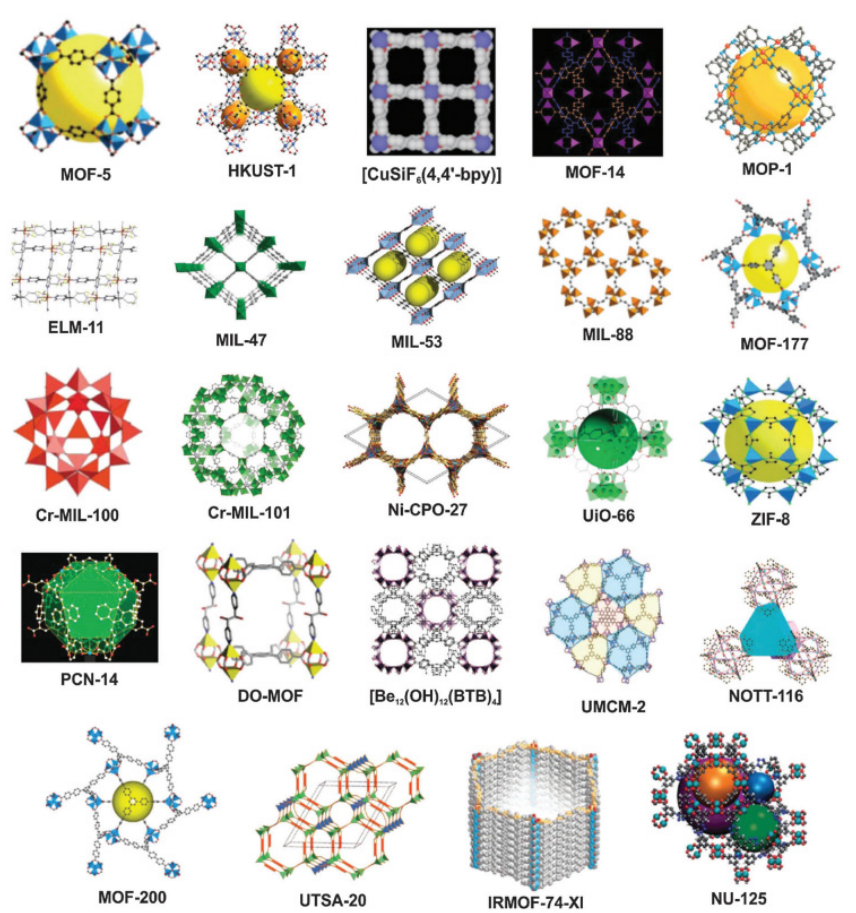
Figure 3. Unit cells showing network topology and void volumes within pores of various representative MOF structures [21].